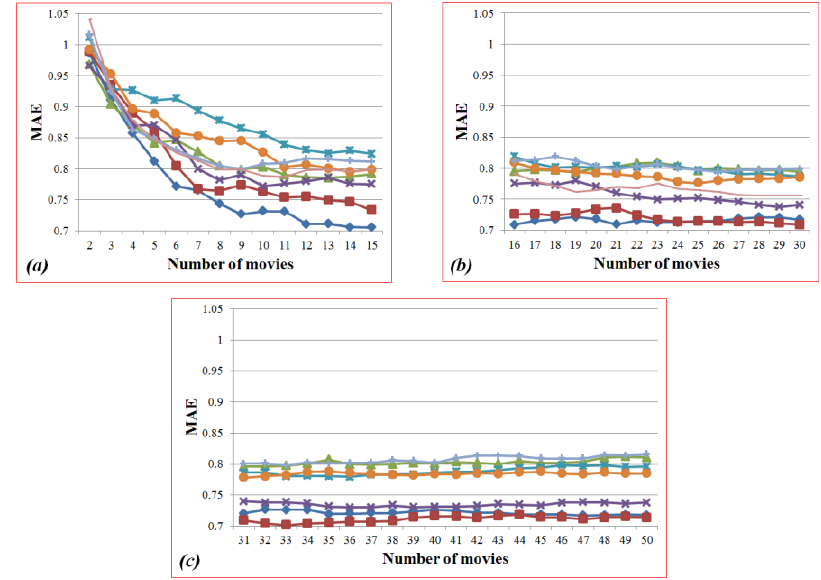
Figure 30. Sub-graphs in Figure 29: ( a ) the ranges from 2 to 15; ( b ) from 16 to 30; ( c ) from 31 to 50.